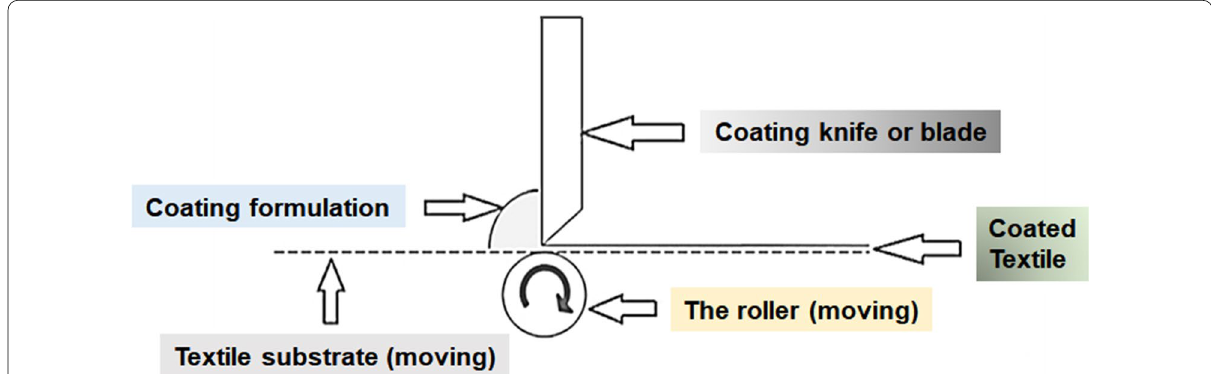
Fig. 9 Schematic illustration of knife-over-roll coating [86] Copyright 2019 Springer International